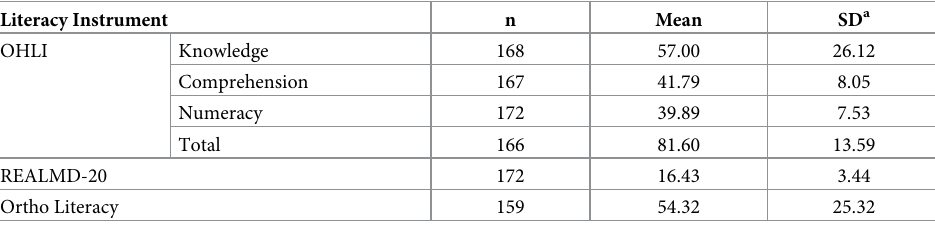
Table 2. Oral health and orthodontic literacy